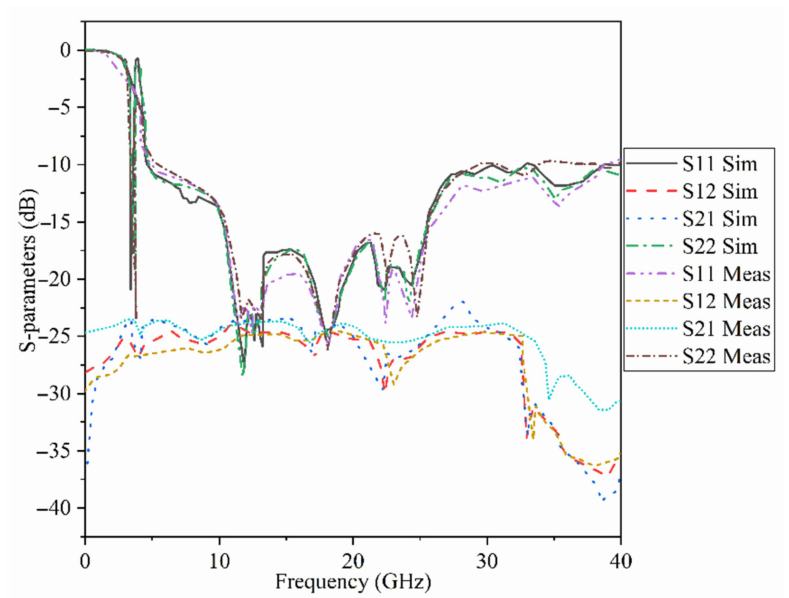
Figure 15. The simulated and measured S-parameters outcomes of the proposed antenna in free space (Sim: Simulation, Meas: Measurement).